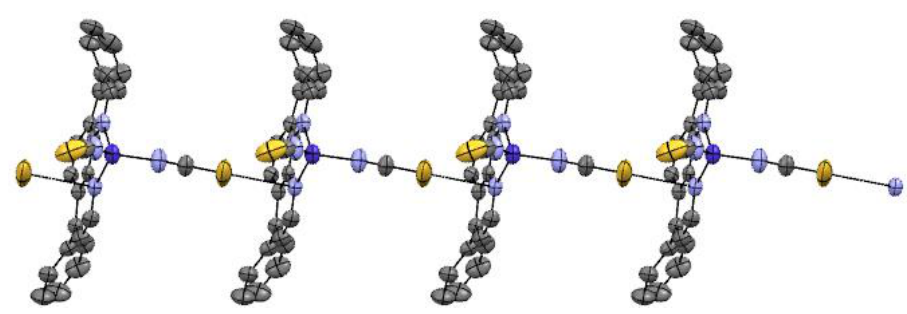
Figure 2. π–π interaction in complex 1 leading to one-dimension chain. Figure 2. π – π interaction in complex 1 leading to one-dimension chain.